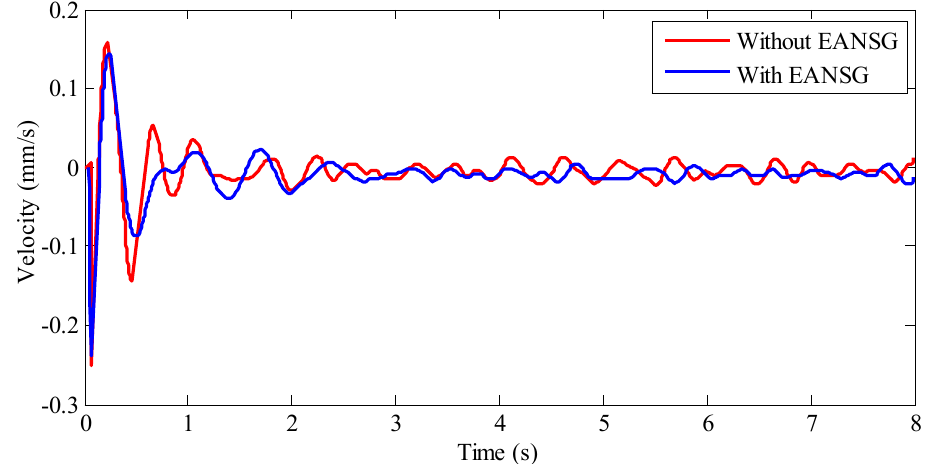
Figure 17. Velocity impact responses of the optical platform supported by either pneumatic springs or low frequency performance enhanced isolators (LFPEIs).